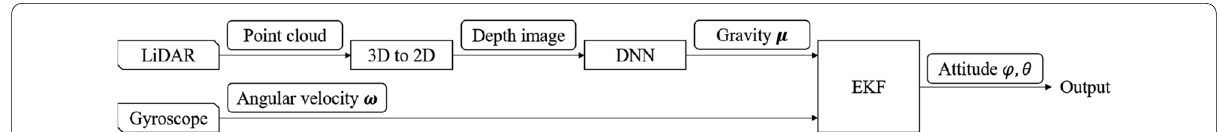
Fig. 6 Proposed EKF architecture. Gyroscopic angular rates are integrated in the prediction process in the EKF. The DNN outputs are integrated in the update process in the